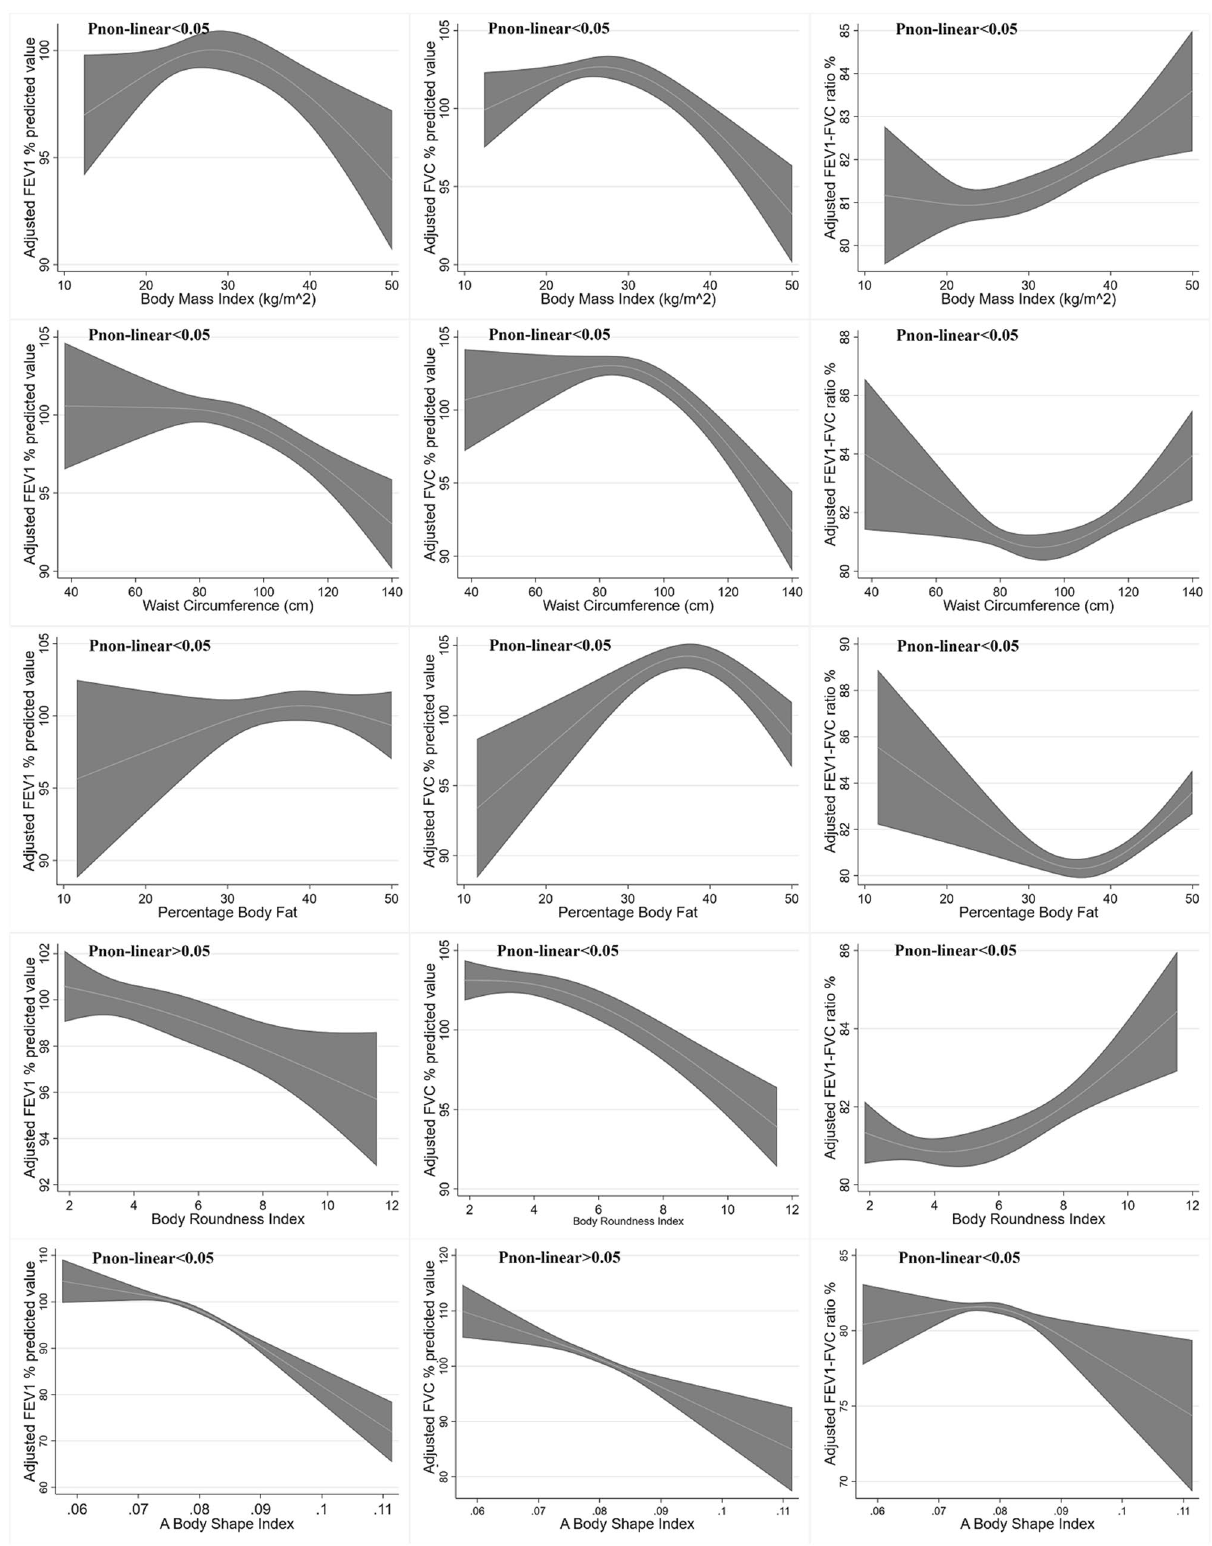
Figure 2. Reverse U-shaped association between BMI, WC, PBF, BRI, ABSI and pulmonary function in female. Data were weighted estimates. The shadow area represents a 95% confidence interval. Pi non-linear was estimated by a two-line piecewise linear model. The model was adjusted for age, race, education, smoking, physical